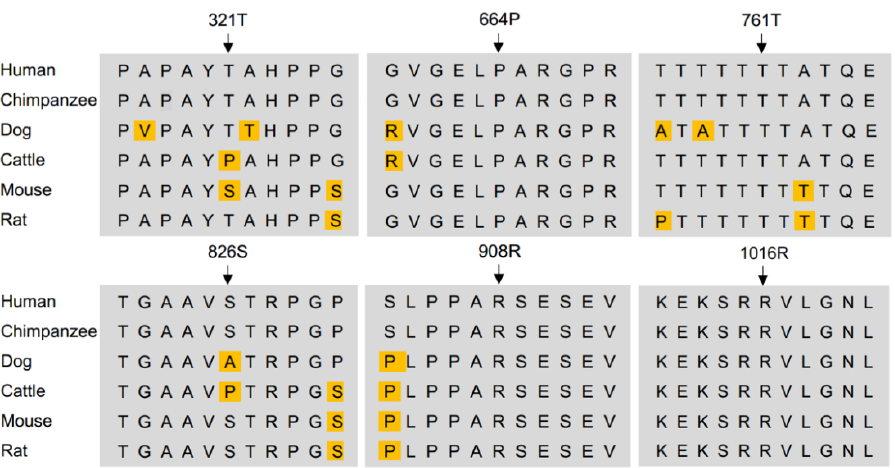
Figure 1. Conservation of amino acid of identified KDM6B variants among species. KDM6B protein sequence of human, chimpanzee, dog, cattle, mouse, and rat were use in the blast.